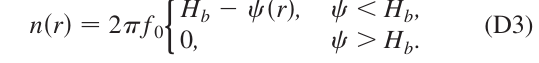
ð k 2 Þ½ 1 (cid:1) 1 =I ð k Þ(cid:6)g is plotted versus the scaled =k 2 r e 0 0 0 (cid:5) 0 0 r , calculated from Eq. (D7) for the indicated 0 r e 0